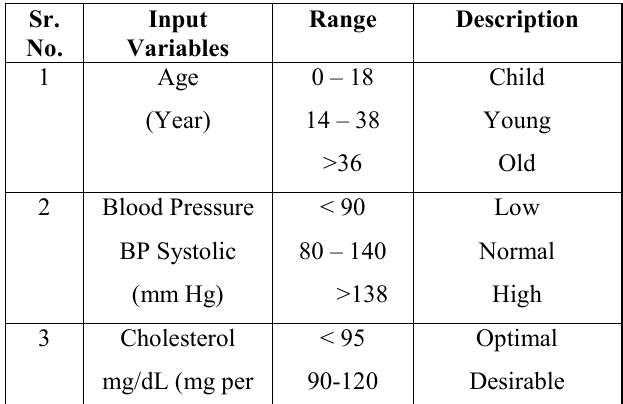
Table 1. Proposed DHD-MFIS Input Fuzzy Sets